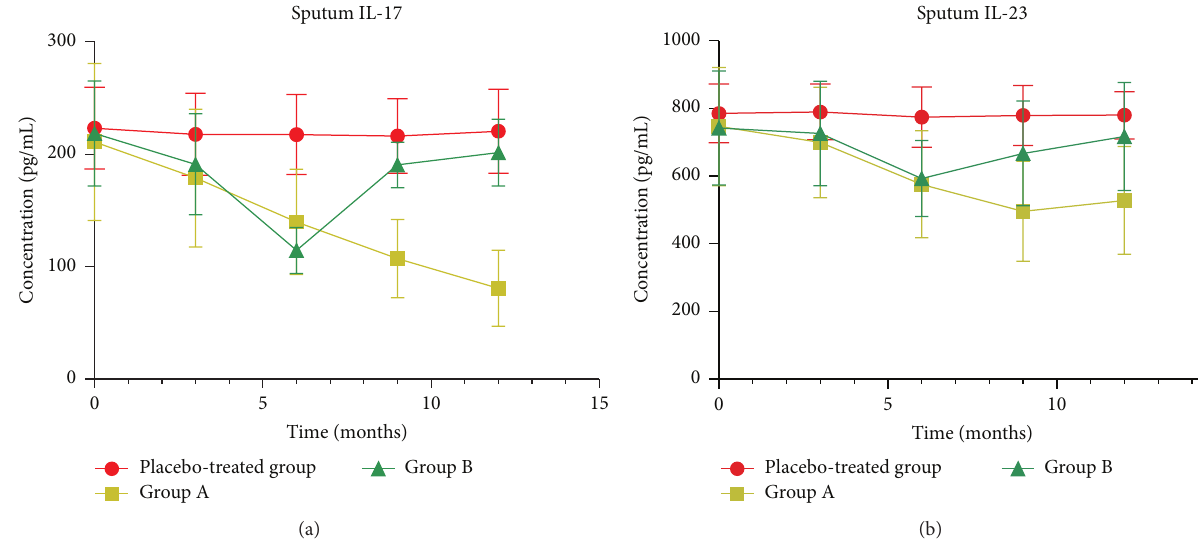
Figure 2: The effects of erythromycin treatment on the concentrations (pg/mL) of IL-17 and IL-23 in sputum from patients with chronic obstructive pulmonary disease at baseline and after 3, 6, 9, and 12 months of treatment. Erythromycin significantly decreased the levels of IL-17 in the sputum after 6, 9, and 12 months of treatment in group A (all 𝑃 values < .001) and after 6 months in group B ( 𝑃 < .001 ) compared to the placebo-treated group. A similar change was observed in IL-23 in patient sputum after 6, 9, and 12 months (all 𝑃 values < .001) in group A and after 6 months of treatment ( 𝑃 < .001 ) in group B compared to the placebo-treated group. Nine and 12 months after erythromycin was discontinued in group B, both IL-17 ( 𝑃 = .06 and 𝑃 = .35 , resp.) and IL-23 ( 𝑃 = .07 and 𝑃 = .63 , resp.) in sputum showed no differences compared to the placebo-treated